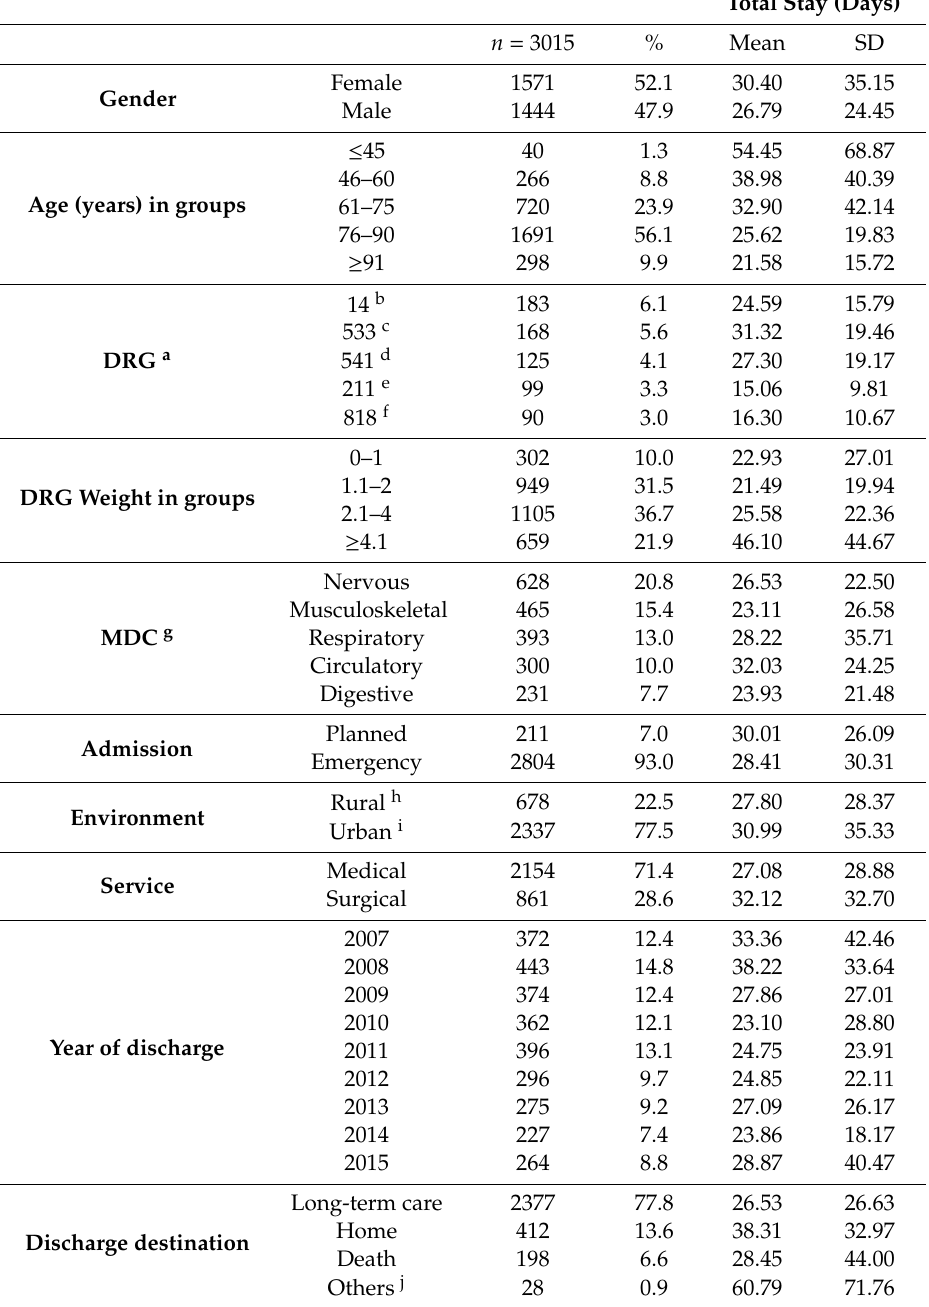
Table 1. General characteristics of the population under study: periods of stay, gender, age, DRG, MDC, admission, environment, service, year of discharge and destination. Cantabria (Northern Spain),